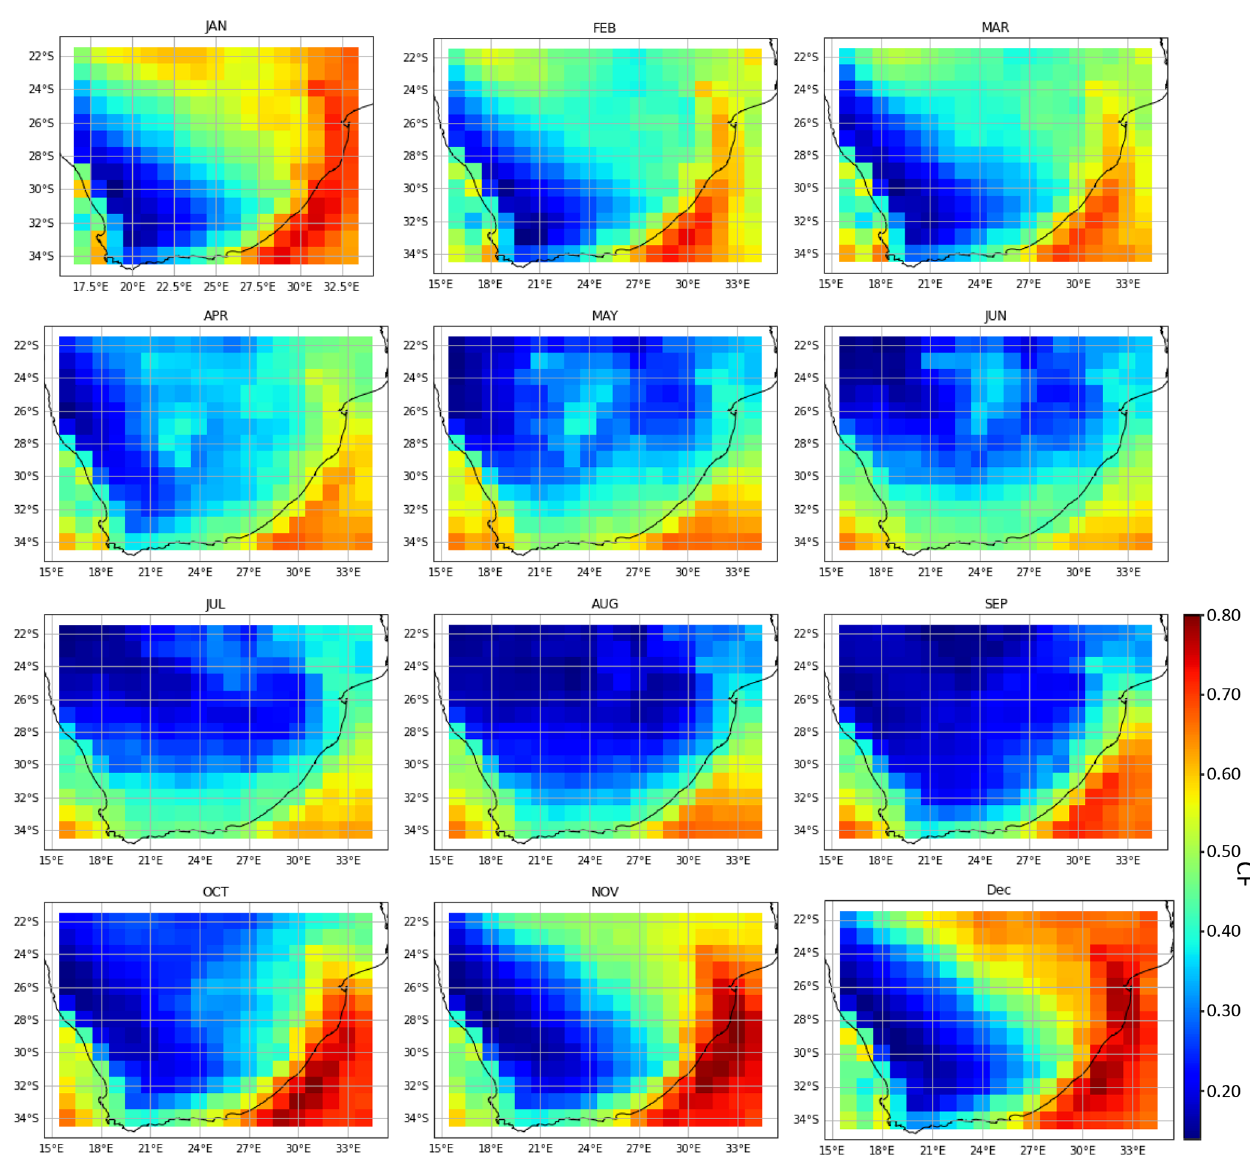
Figure 8. Average spatial distribution of cloud fraction (CF) over South Africa from MODIS data for 10